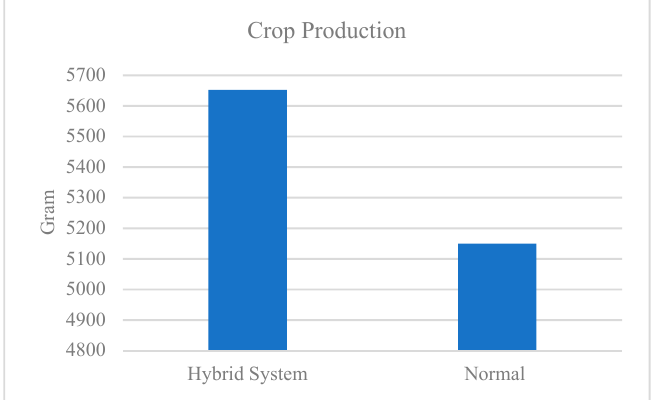
Figure 22. C omparison of strawberry productions.